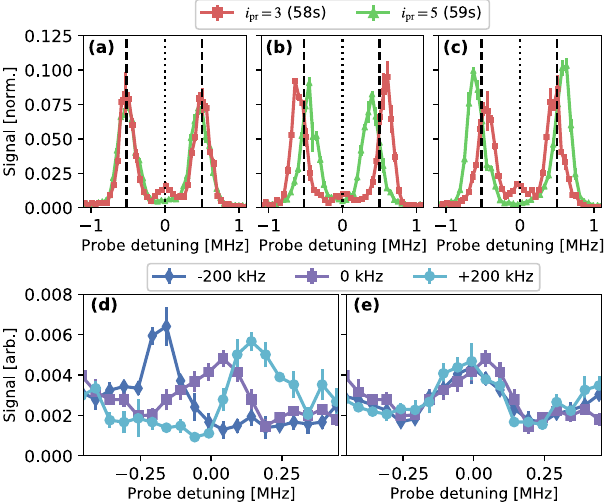
Fig. 6 Band structure with Hamiltonian perturbations. ( a ) SSH model: δ = 0 with balanced tunneling rates ( J J = J 0 J 0 = J ¼ 5). Lines i w s and s 2 − 3 , 4 − 5 mark positions of the bulk and edge peaks. ( b ) Strong tunneling rates are imbalanced to J 2 (cid:2) 3 ¼ 1 : 15 J 0 s and J 4 (cid:2) 5 ¼ 0 : 85 J 0 s for J 0 s = J w ¼ 5. This perturbation respects chiral symmetry. ( c ) Same as ( b ) but J 2 (cid:2) 3 ¼ 0 : 85 J 0 s and J 4 (cid:2) 5 ¼ 1 : 15 J 0 s . ( d ) Edge state spectra in the presence of perturbations breaking chiral symmetry: tunneling rates are balanced as in the standard topological SSH con fi guration, with J s / J w = 10, but the frequency of the i = 1 Fig. 7 Noise model analysis. Fits of experimental data with theoretical to i = 2 (57 s -57 p ) coupling is varied by the value given in the legend. calculations assuming no decoherence ( ), and using the amplitude- Spectra are recorded with the probe laser tuned near the 58 s level ( i pr = 3). noise model [Eq. (6), ]. Data shown are for J s / J w = 15 [from Fig. 2c, ( e ) Same as ( d ), but the i = 5 to i = 6 (59 s -59 p ) coupling frequency is the i pr = 3, 5 spectra have been multiplied by a factor of 2 for clarity]. All varied. All error bars denote one s.e. of the mean. error bars denote one s.e. of the